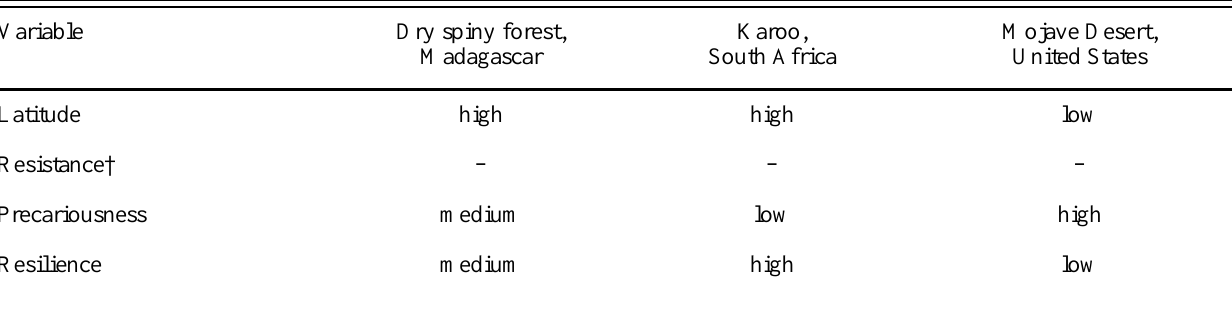
Table 2. Evaluation of resilience and its components in a comparison of the status of tortoises from three arid